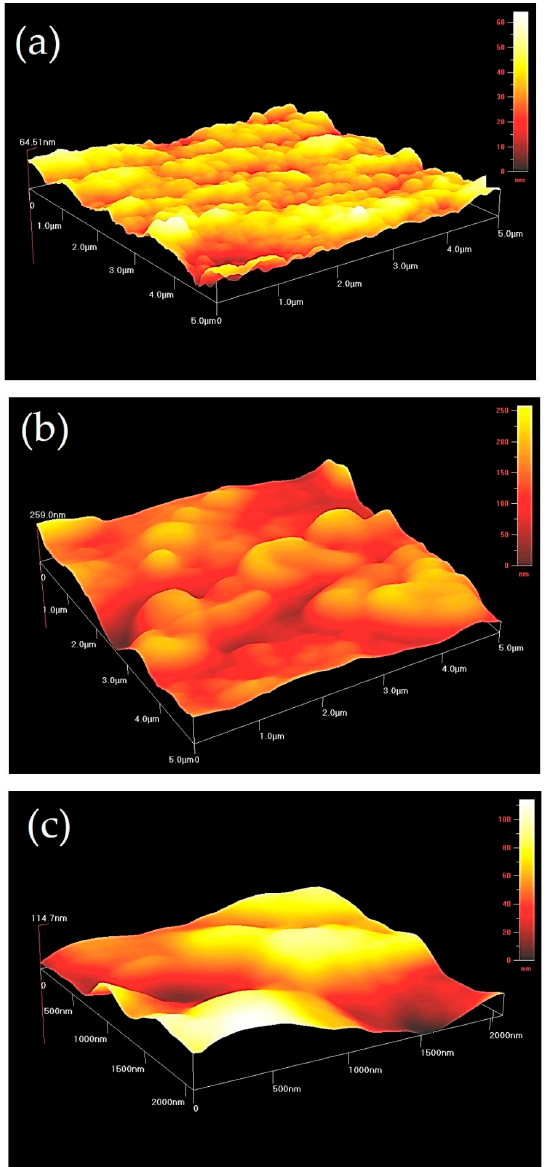
Figure 4. AFM image of titanium nanoparticles formed by: ( a ) Bacillus subtilis , ( b ) Cassia fistula and ( c ) hydrothermal heating showing surface roughness.